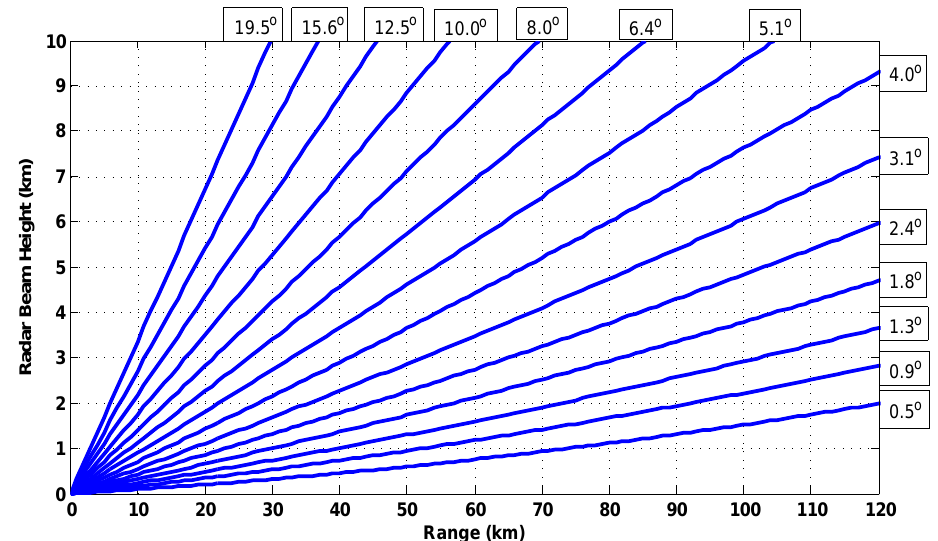
Fig. 1. Beam height vs. radar range at the elevation angles corresponding to one of the scan strategies of WSR-88D